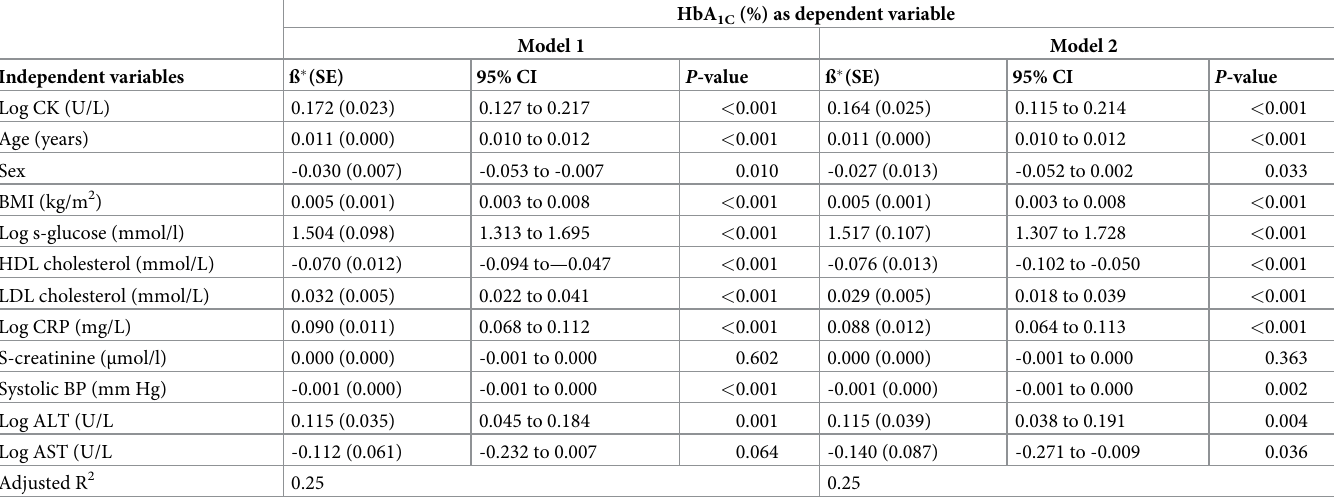
Table 2 compares log CK with HbA (%) quartiles. The main results were a significant lin- 1C ear association between higher log-CK levels and increasing HbA (%) in women and a simi- 1C lar significant, but nonlinear relationship in men. Table 2 also shows the relationships for confounders. All variables positively associated with HbA (%) in the variance analyses were 1C Table 3. Multiple regression analyses comparing glycated haemoglobin (dependent variable) with independent